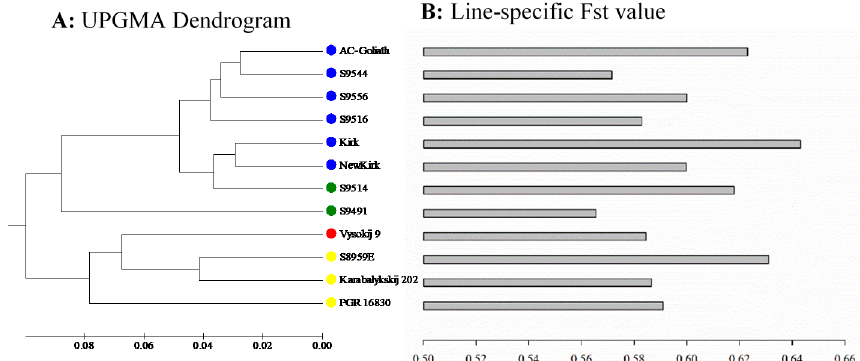
Figure 5. Genetic diversity and genetic relationships of the 12 crested wheatgrass lines. Left panel ( A ) shows their genetic relationship in the unweighted pair group method with arithmetic mean (UPGMA) dendrogram based on the Phi statistics obtained from the AMOVA. The right panel ( B ) displays the line-specific F st values for the 12 lines.